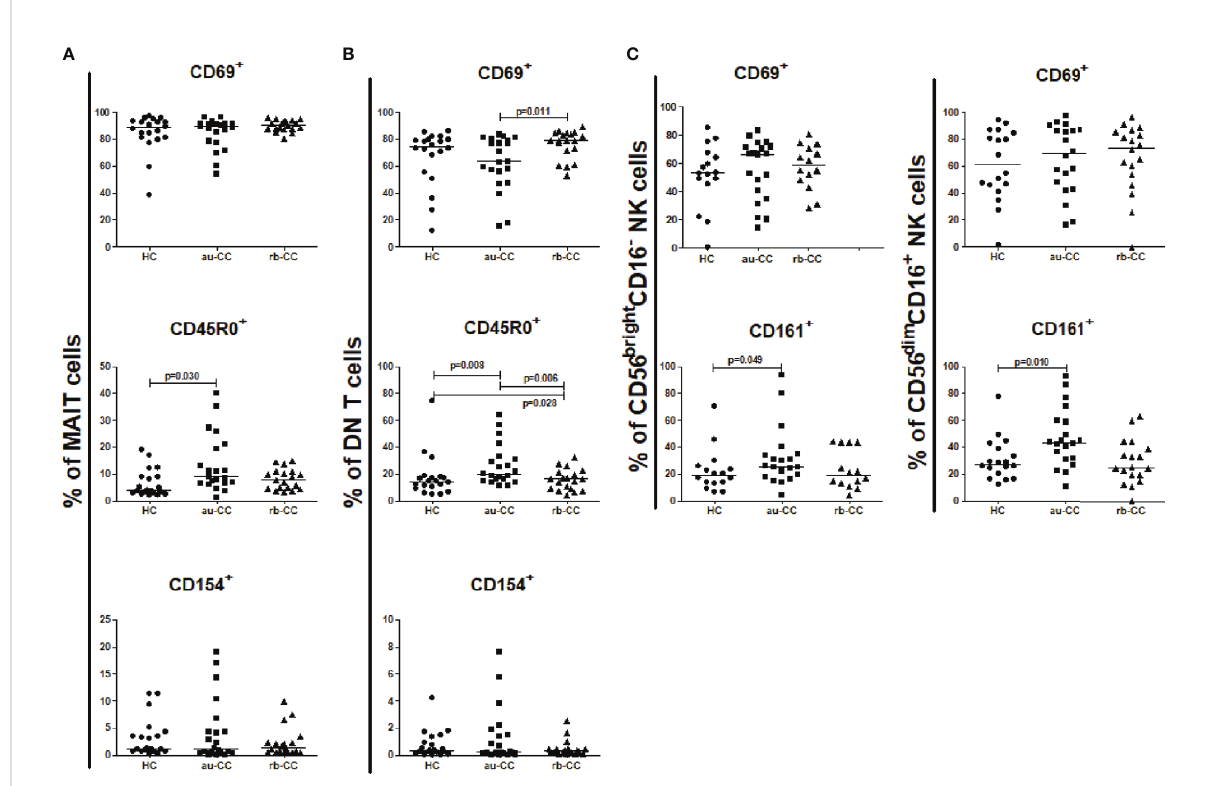
FIGURE 5 Frequencies of mucosal activated and memory subpopulations of MAIT cells (A) , DN T cells (B) , CD56brightCD16- and CD56dimCD16+ NK cells (C) in collagenous colitis. Analysis performed with fl ow cytometry. Statistically signi fi cant differences are p<0.01, statistical trends are p<0.05. au, active/untreated; CC, collagenous colitis; HC, healthy controls; rb, remission/budesonide. CD69, CD154 and CD161 are activation markers and CD45R0 memory